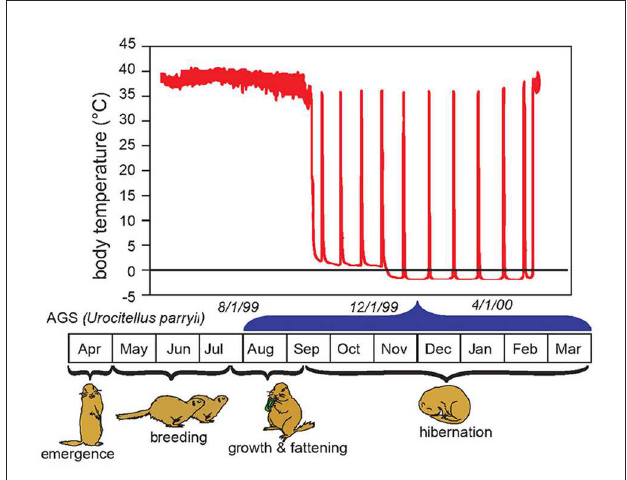
FIGURE1 Body temperature in relation to life cycle and season of the hibernating arctic ground squirrel (AGS). The hibernation season, also referred to as hibernation, is marked by repeated bouts of prolonged torpor, termed here as hibernation torpor. Hibernation torpor is interrupted by spontaneous interbout arousals (IBA) noted by rapid increases in body temperature. Spontaneous IBAs are observed in all species of hibernators when core body temperature falls below 30 ◦ C (26). During arousal from hibernation, the nadir of mammalian metabolism is over-ridden by the high energetic costs of warming core body temperature from near 0 ◦ C to ∼ 35 ◦ C in 2–3h. During repeated recovery from hibernation oxygen consumption surges 300 fold from about 0.01 mLO 2 g − 1 h − 1 to about 3 mLO 2 g − 1 h − 1 (27). Arousal from torpor may be spontaneous or induced by external stimuli such as gentle handling. Once initiated, evidence suggests induced arousals proceed in the same way as natural arousals with the exception that induced arousals are faster and may be